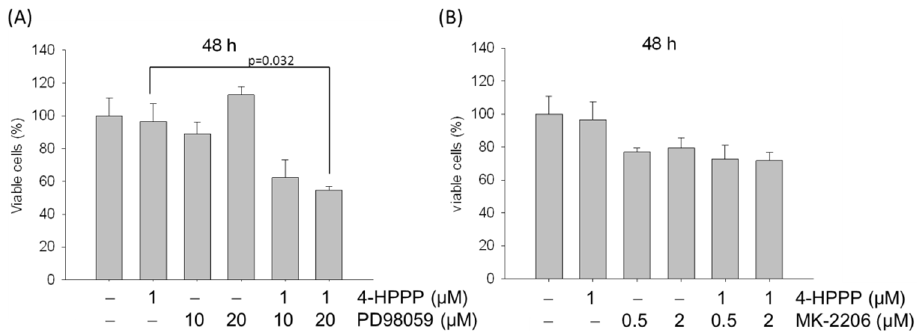
Figure 9. The effect of MEK1/ERK and Akt inhibitors on 4-HPPP-induced inhibition of Ha22T cells. Ha22T cells were subject to treatment with 4-HPPP alone or ERK and Akt inhibitors for 6 h prior to 4-HPPP administration for 48 h. The result of trypan blue dye assay is represented. Specific inhibitors, PD98059 for MEK1/ERK and MK-2206 for Akt, before 4-HPPP administration respectively.